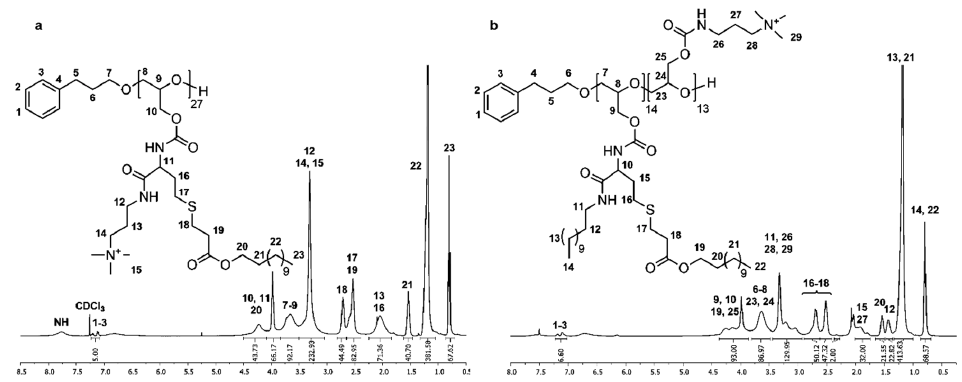
Figure 3. 1 H NMR spectra of P(G DDAc, q ) 27 ( 10 ) measured in CDCl 3 ( a ) and P(G TMAPA14 - co -G DDADDAc13 ) ( 12